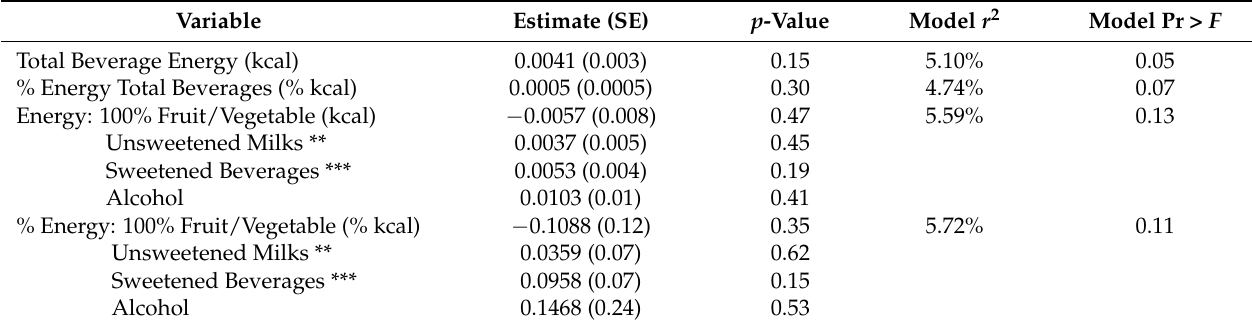
Table 3. Regression Analyses of the Relationship between BMI (continuous outcome) with Total and Percent Energy from Total Beverages and Classes of Beverages (continuous exposures) Adjusting for Demographic Characteristics